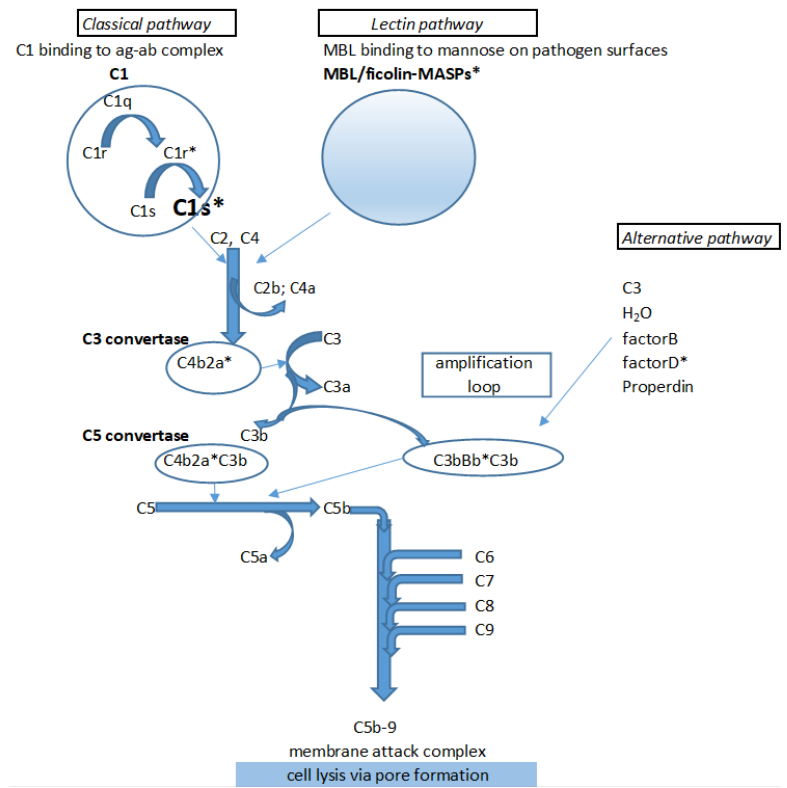
Scheme 1. Schematic overview of the activation of the complement system via its activation pathways highlighted C1s, the enzyme transducing activation signal from C1 to the next step in the activation cascade via activating, i.e., cleaving C2 and C4